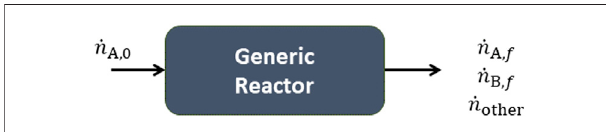
FIGURE 3 | A continuous- fl ow thermochemical reactor with an input molar feed rate of _ n A , 0 , and a product stream with out fl ows _ n A , f , _ n _ n other B , f and.